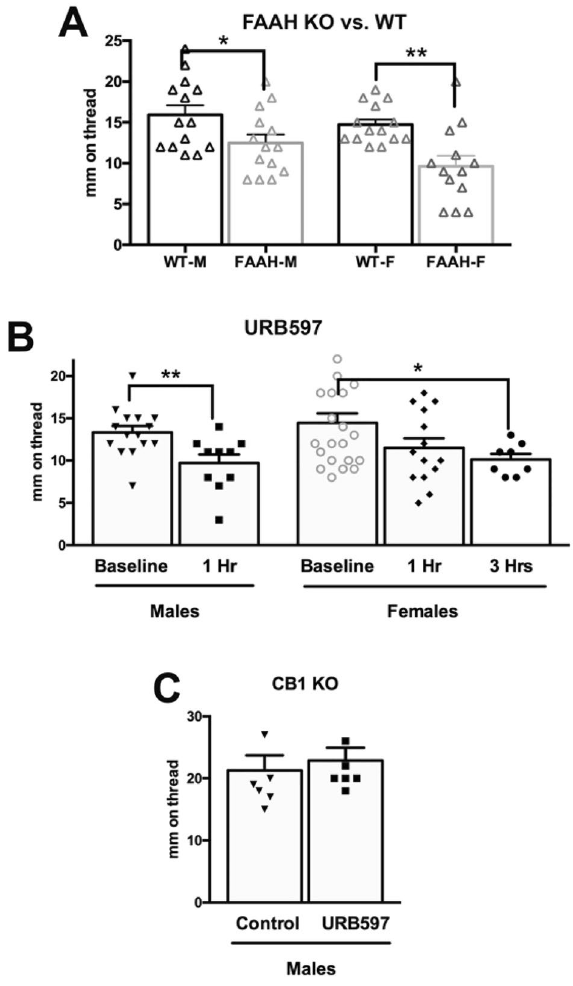
Figure 4. FAAH deletion and blockade reduces salivation. ( A ) Male and female knockout mice saw lower baseline salivation. ( B ) Treatment with the FAAH blocker URB597 (4 mg/kg) reduced salivation at 1 h in males and at 3 h in females. ( C ) URB597 did not alter salivation in male CB1 knockout mice. *p < 0.05, *p < 0.01 unpaired